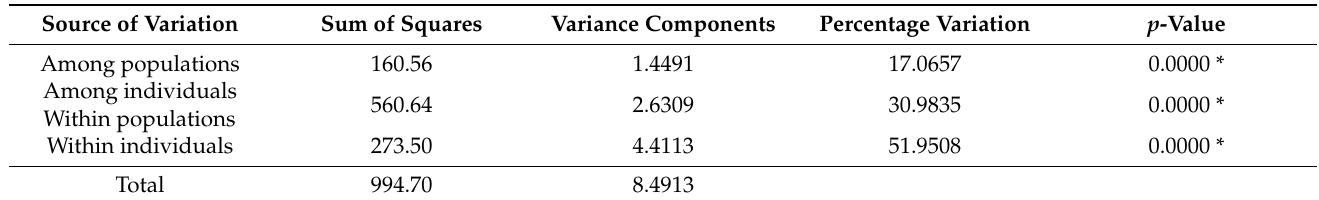
Table 2. Analysis of molecular variance (AMOVA) of N. shimadai populations in northern Taiwan using 39 SSR loci.